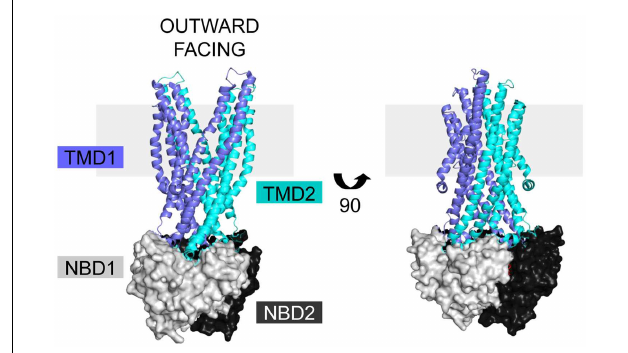
FIGURE 2 | CFTR homology models are based on theABC exporter structures. The Sav1866 (pdb 2HYD) exporter is shown with domains colored based on representative CFTR domains, withTMD1 (blue), NBD1 (light gray),TMD2 (cyan), and NBD2 (black).There is no homologous structure for the CFTR R domain.The structure is in the outward facing configuration, which for CFTR is the open channel.The view is shown in the plane of the membrane (gray